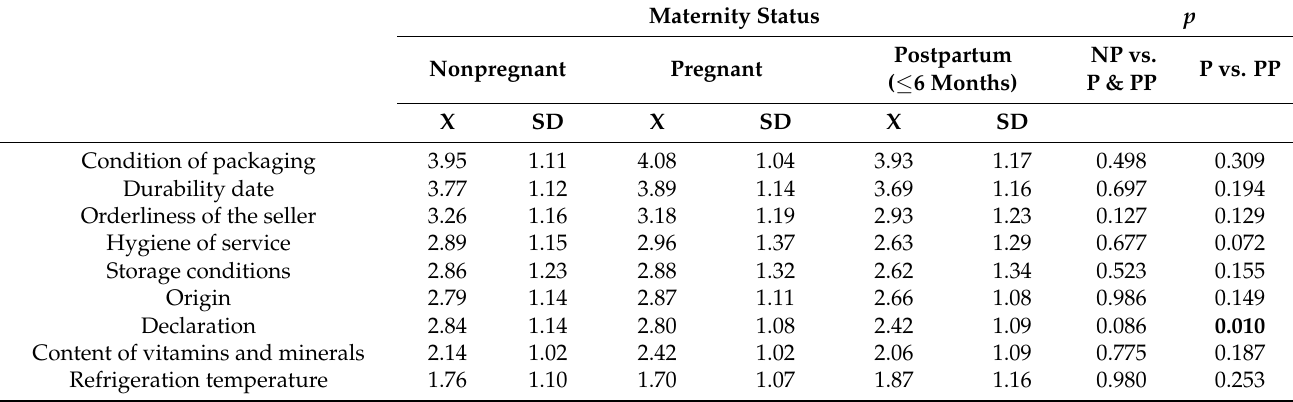
Table 4. Frequency (arithmetic mean) of checking food characteristics, storage and hygiene conditions when purchasing food by maternity status, listed from highest to lowest overall arithmetic